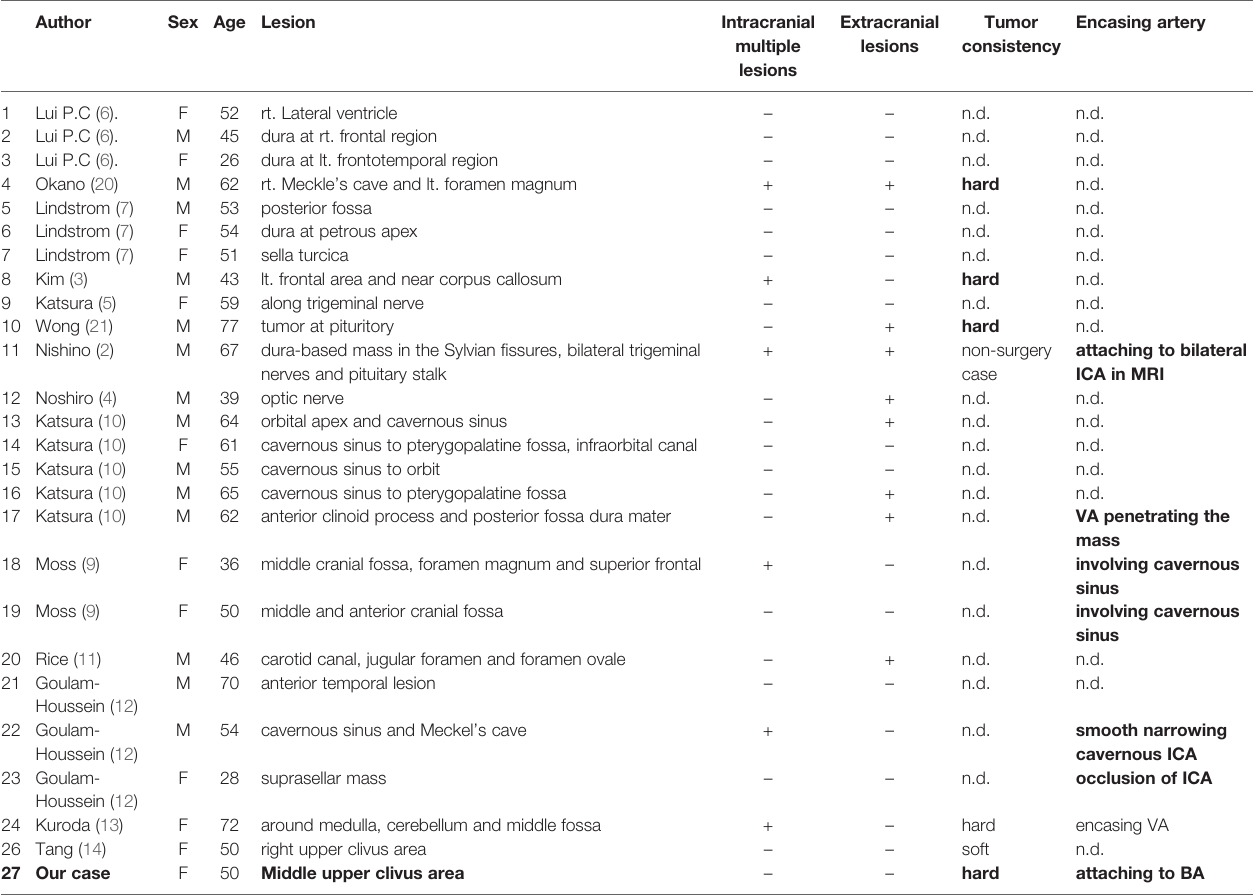
Bold values represent our case. n.d., not